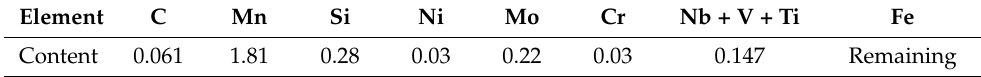
Table 9. Chemical composition of steel of strength class X80 (wt.%) [34].